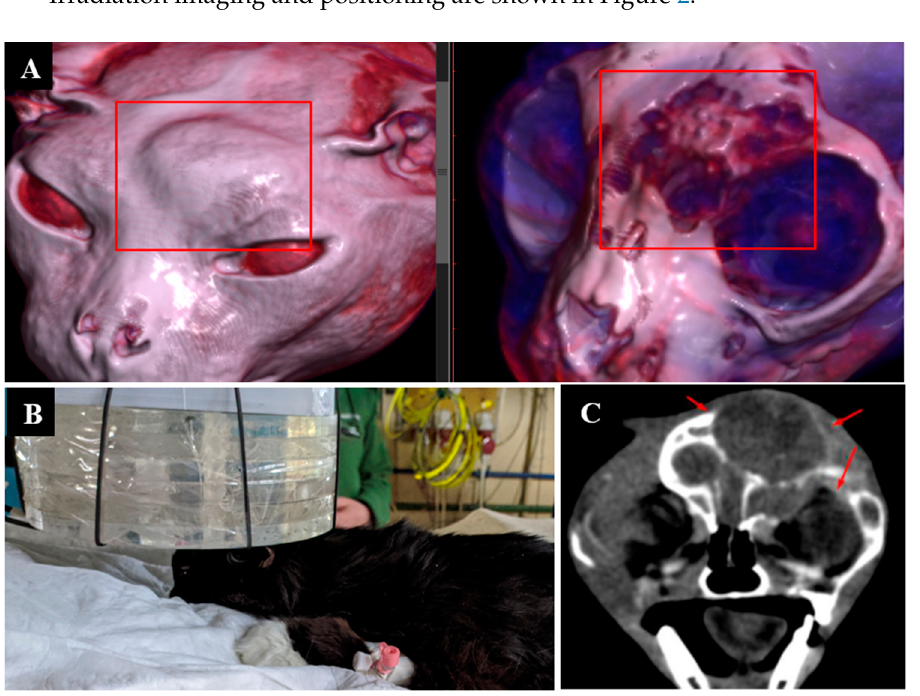
Figure 2. A cat named “Perchik”. ( A )—CT of the head, chest and abdomen before irradiation. ( B )—positioning of the animal during the irradiation session. ( C )—CT of the head 2 months after irradiation.